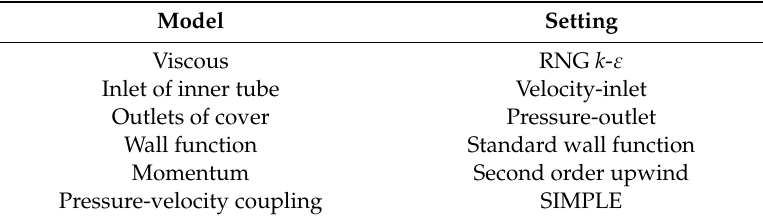
Table 2. Boundary conditions and model